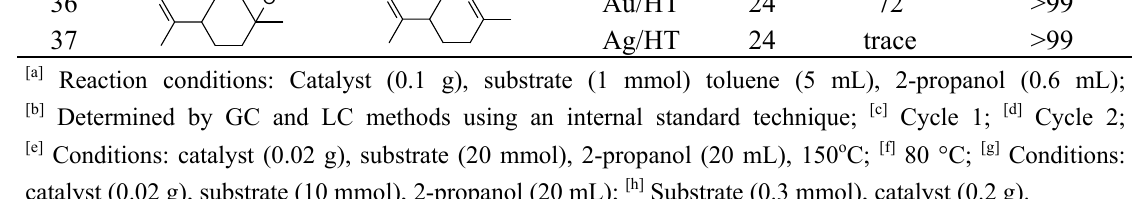
Figure 6. Heterolytic dissociation of H